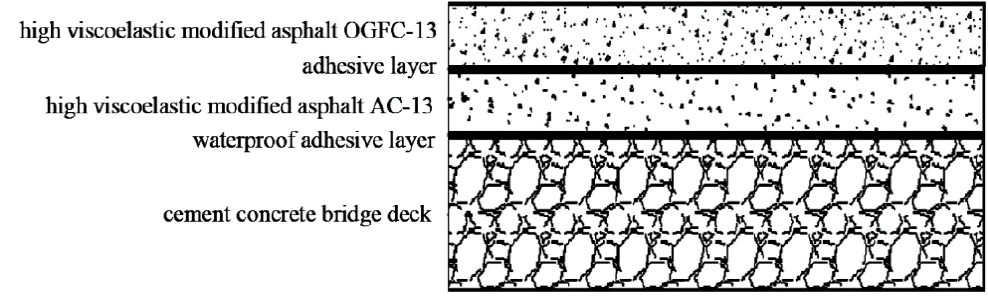
Figure 1. Bridge deck pavement